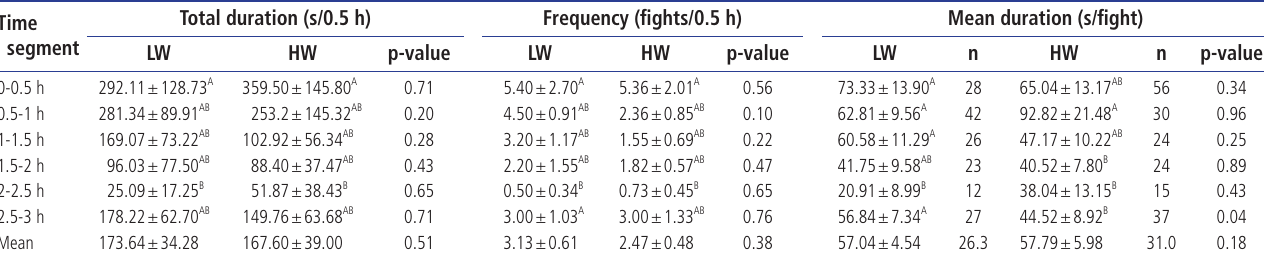
Table 1. Differences in fighting behaviors between LW group and HW group within first 3 hours after regrouped Time segment